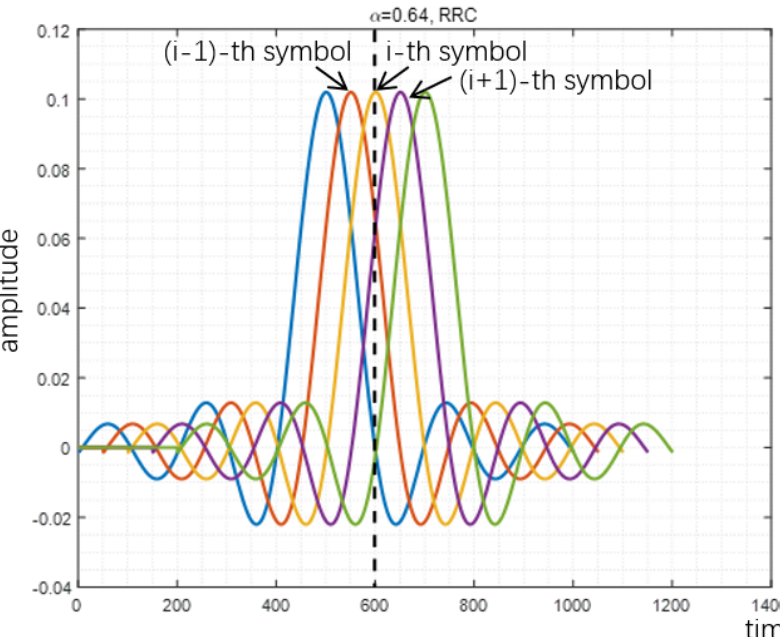
Figure 8. Peak value of RRC filter-based signal with α = 0.64.